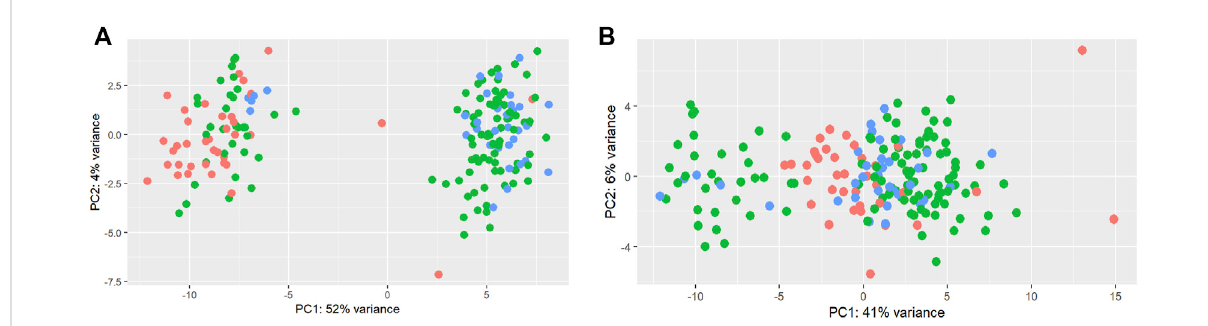
Principal component analysis of total counts as a batch effect in miRNAs. Principal component analysis of miRNAs before (A) and after (B) the limmabatcheffectnormalization.Thetotalcountsrefertothetotalnumberofreadspersample.Threecolorswereusedtorepresent1)sampleswith a higher total number of reads: higher than mean +standard deviation (345,281 reads) (blue); 2) samples with a lower total number of reads: lower than mean — standard deviation (125,193 reads) (red); 3) samples with the average total number of reads: between mean > + standard deviation and mean < + standard deviation (green).